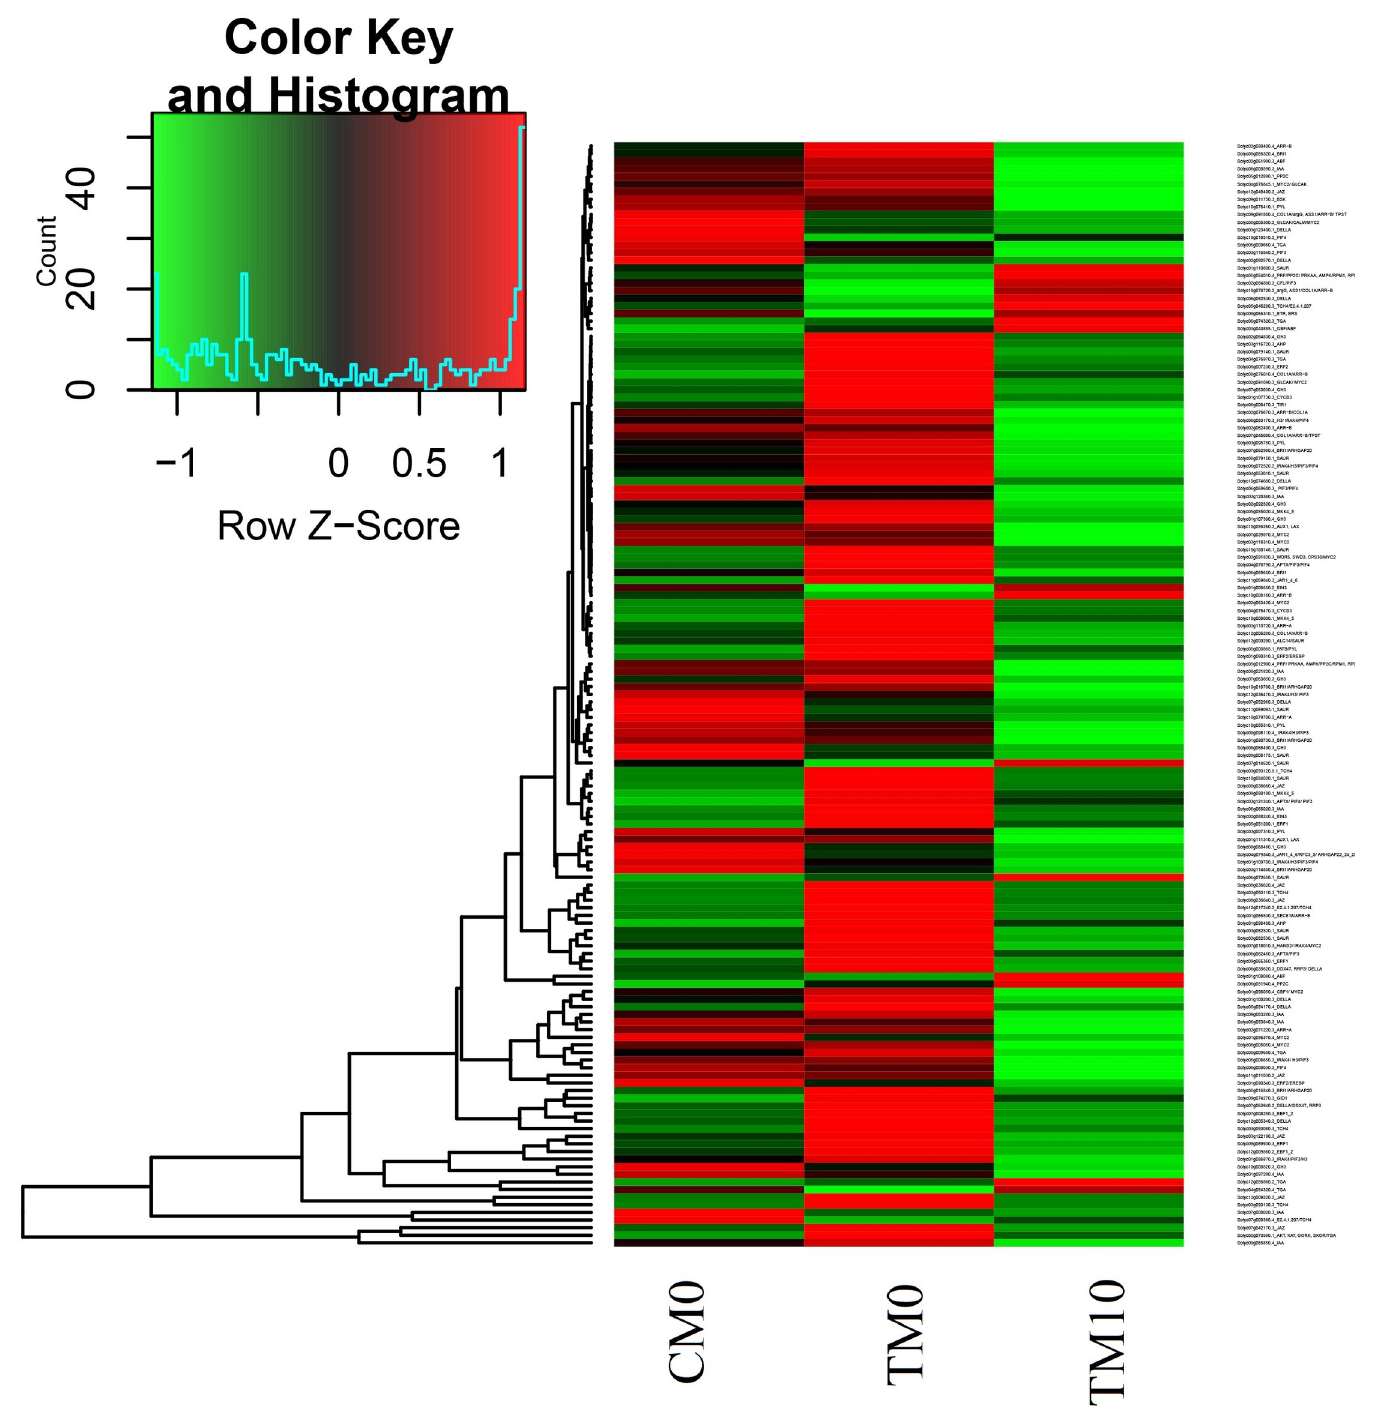
Fig 7. The expression profiles of the DEGs involved in different hormone signaling pathways in groups of CM0, TM0 and TM10. https://doi.org/10.1371/journal.pone.0267594.g007 CM10-vs-CM0 comparison groups were paid attention. The results showed that the two com- parison groups had 214 DEGs in common, and number of DEGs specific belonging to TM10-vs-TM0 was 3044 (Figs 3B and 8A). Subsequently, the 3044 DEGs were analyzed by GO